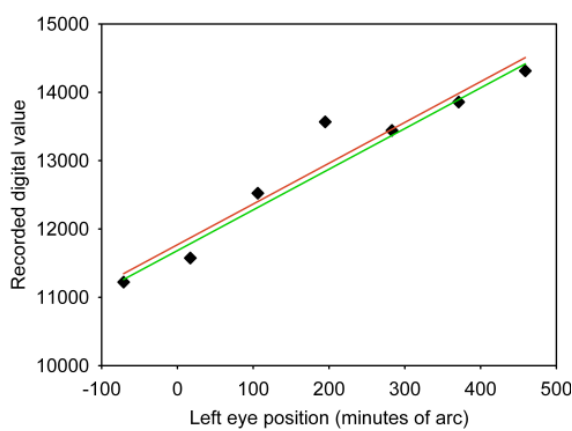
Examples of calibration regressions: LS algorithm versus robust regression. The red regression line reflects the LS and the green line the robust